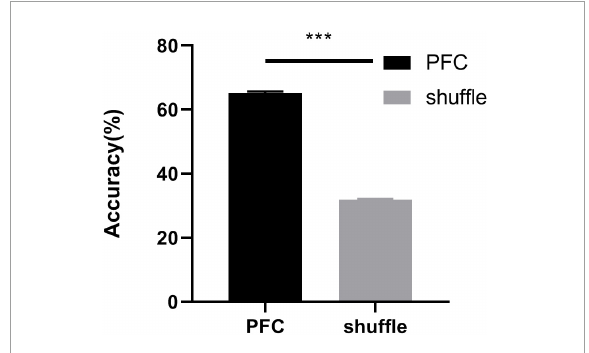
FIGURE6 Decoder accuracy for real PFC data and shuffled data. The classification accuracy was evaluated using a support vector machine jointly discriminated the social behavioral states (real data: 65.16% ± 0.51%, shuffled data: 31.87% ± 0.20%, unpaired t -test, *** p <